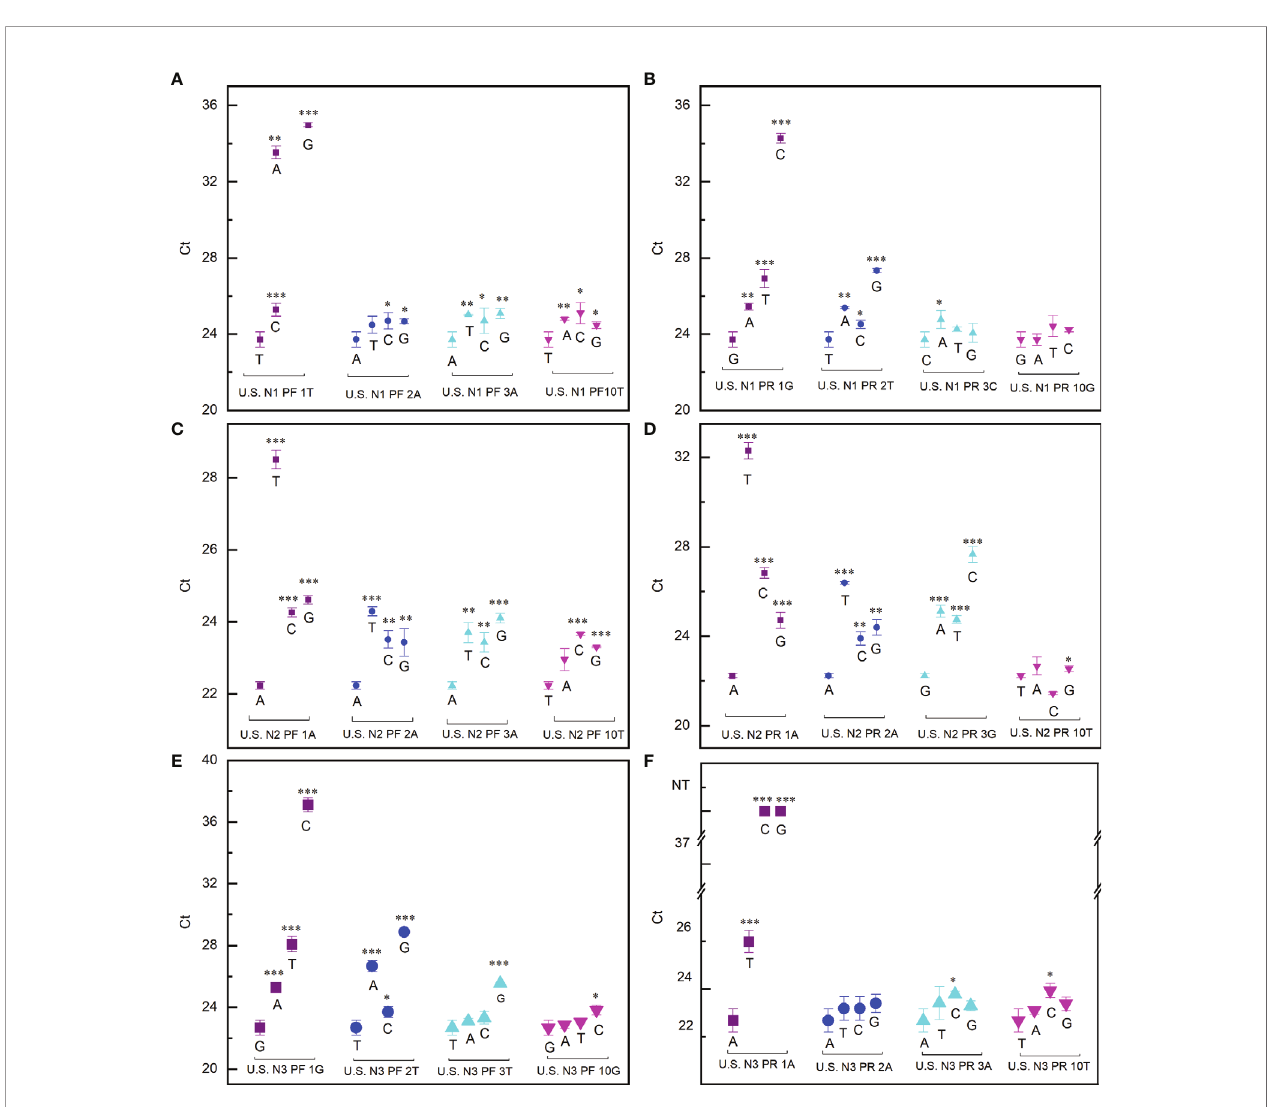
FIGURE 1 | Effect of mismatch between primers and template on PCR reaction. (A, B) Ct values detected when the US N1 forward primer (A) and reverse primer (B) contained mismatch with the template. (C, D) Ct values detected when the US N2 forward primer (C) and reverse primer (D) contained mismatch with the template. (E, F) Ct values detected when the US N3 forward primer (E) and reverse primer (F) contained mismatch with the template. The purple square, blue dot, cyan upper triangle, and magenta lower triangle represent the fi rst, second, third, and 10th (middle position) base of the 3 ′ end of the primer, respectively. Student ’ s t -test by SPSS 15 was used for data analysis. A p -value < 0.05 was considered statistically signi fi cant. * p < 0.05; ** p < 0.01; *** p <